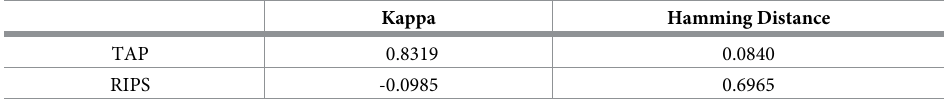
Table 7. Evaluation criteria of multiclass classification